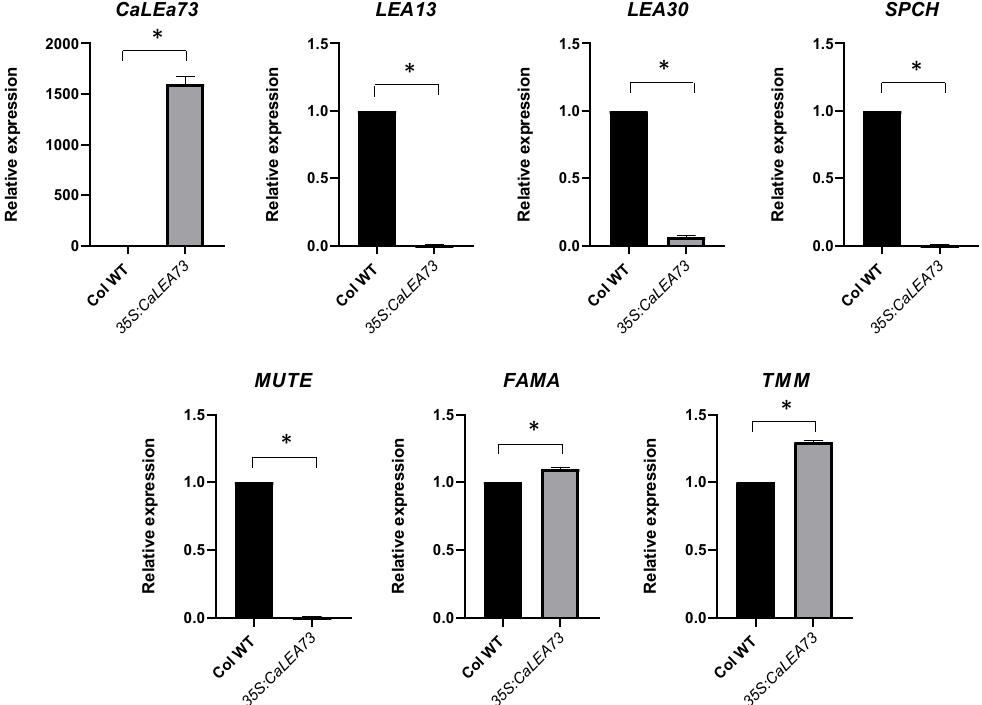
Figure 7. Analysis of the gene expression of lea13 , lea30 and markers of stomata development in the 35S:LEA73 genetic background. Cotyledons of seedlings 15 days after germination (dpg) growth under normal irrigation conditions were analyzed. Y-axis: relative expression (2 − ∆∆ CT ). * Data represent samples significantly different p < 0.05. All tests were performed using 3 biological and technical